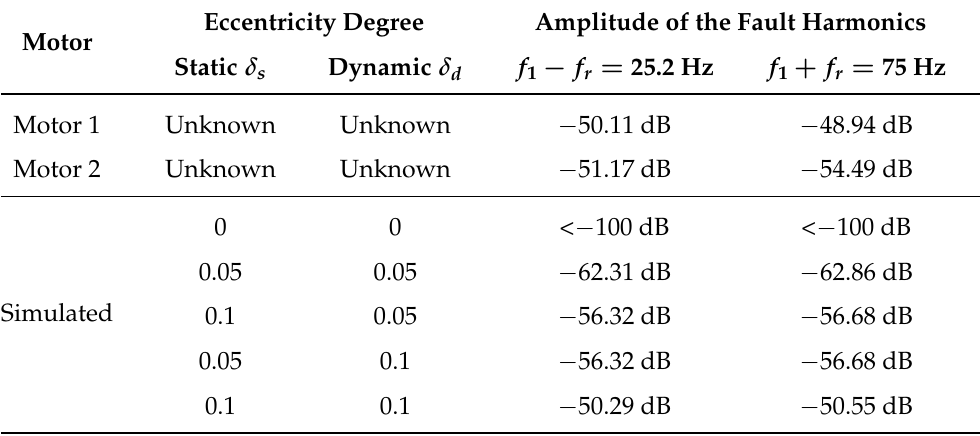
Table 2. Amplitude of the fault harmonics corresponding to the experimental tests and the simulated motor